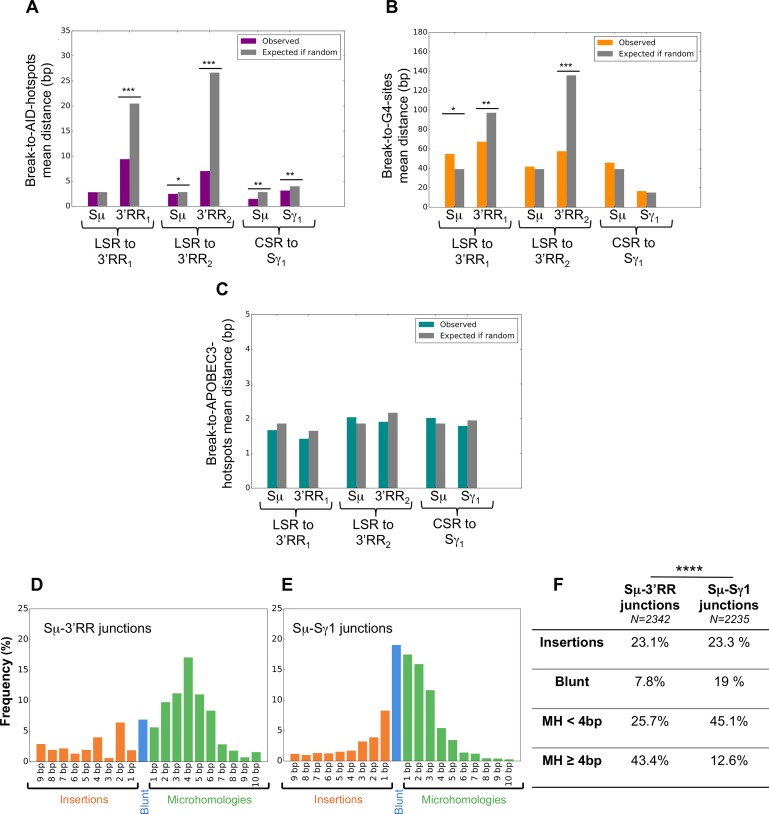
Detailed position of breaks and structure of human repaired LSR junctions.Mean distance to AID target sites (A), G-quadruplex (B) and APOBEC3 family (C) sites. Structure of repaired junctions with regards to mean number of inserted nucleotides and length of microhomologies between broken ends for Sμ-3’RR (D), Sμ-Sγ1 (E). Comparison of LSR vs CSR junction structure in percentage (F).